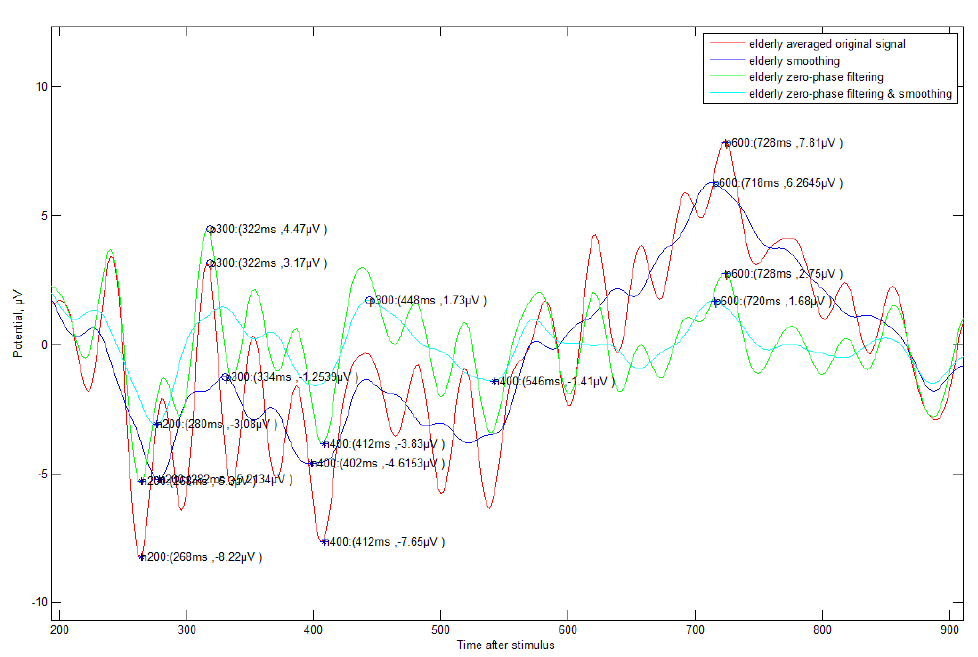
Figure 8. ERP Case Study 2—Elderly subject (#9)’s incorrect answer about triangle symbol: The fluctuation is more severe compared to the correct data, and the detection time is somewhat